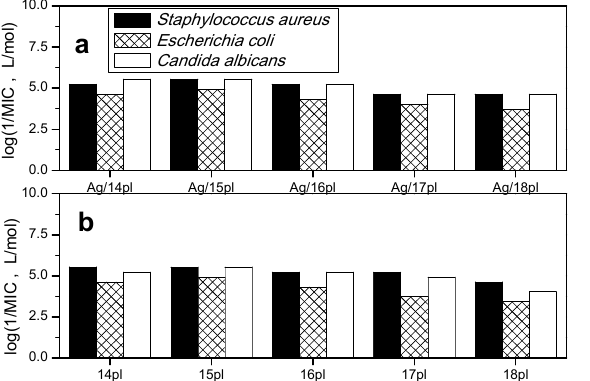
Figure 8. Plot of logarithm of inverse minimum inhibitory concentration log(1/MIC) determined against Gram-positive, Gram-negative bacteria, and a yeast pathogen for ( a ): AgNPs nanodispersions stabilized with alkyldimethylphenylphospholium bromides and ( b ): for aqueous solutions of these surfactants.